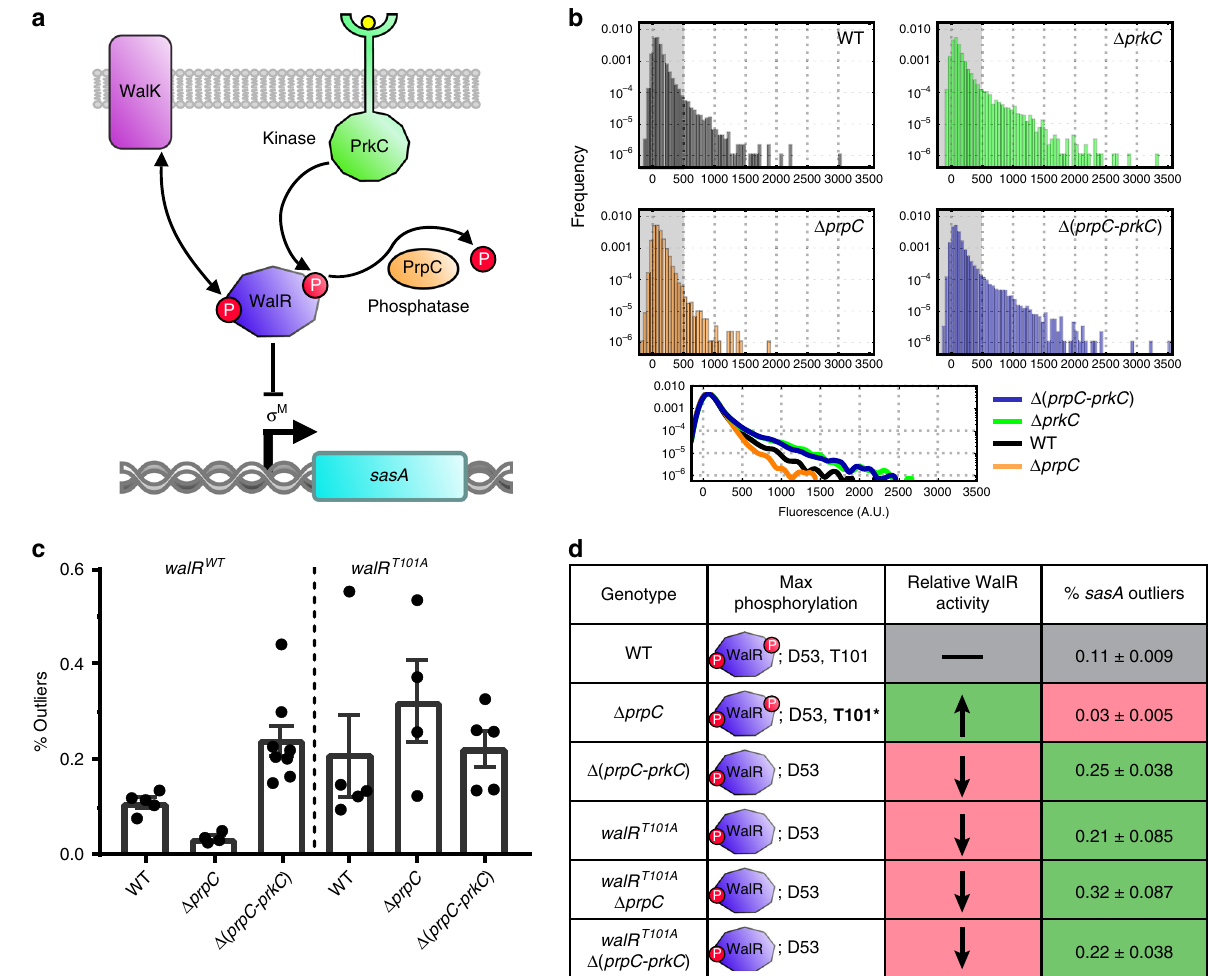
Fig. 2 The Ser/Thr kinase PrkC and phosphatase PrpC regulate cell-to-cell variability in sasA . a Model for PrkC-dependent regulation of sasA . WalR binding to the sasA promoter represses sasA expression. WalR activity is primarily controlled by phosphorylation on Asp-53 by its cognate histidine kinase WalK, and secondarily by phosphorylation on Thr-101 by the Ser/Thr kinase PrkC. WalR Thr-101~P can be dephosphorylated by the phosphatase PrpC. Thr-101~P further enhances the repressing activity of WalR Asp-53~P, resulting in lower expression of sasA under conditions with high Thr-101~P (e.g., Δ prpC ). Under conditions lacking Thr-101~P (e.g., Δ prkC ), the increased repression of sasA is relieved. b Histograms demonstrating PrkC-dependent cell-to-cell variability in sasA . Top: P sasA - yfp reporter activity was quanti fi ed by fl ow cytometry in wild type (WT, gray), Δ prpC (orange), Δ prkC (green), and Δ ( prpC-prkC ) (blue) backgrounds. Shaded region of each plot indicates the range of cellular auto fl uorescence observed. Each histogram was computed from data on ~3.0 × 10 4 events. Bottom: Smoothed, overlaid histograms of the data shown above for comparison. c Percentage of outliers in each genetic background. At least 4 independent experiments, similar to and including the representative one shown in b , were performed in walR WT (Left) and walR T101A (Right) backgrounds. Each experiment was normalized to a control and outliers were de fi ned as cells above a fi xed threshold level of normalized fl uorescence (~1250 A.U.). Dots represent the percentage of each population that is above the threshold; bars and lines represent the mean and SEM, respectively. d Summary of each genotype, its effect on the maximal occupancy of the two known WalR phosphosites, and the expected effect on WalR activity relative to WT. For each genotype the mean percentage of outliers in sasA expression (shown in c ) is also summarized. Note that in the Δ prpC background, the Thr-101 phosphorylation is stabilized (denoted as T101*